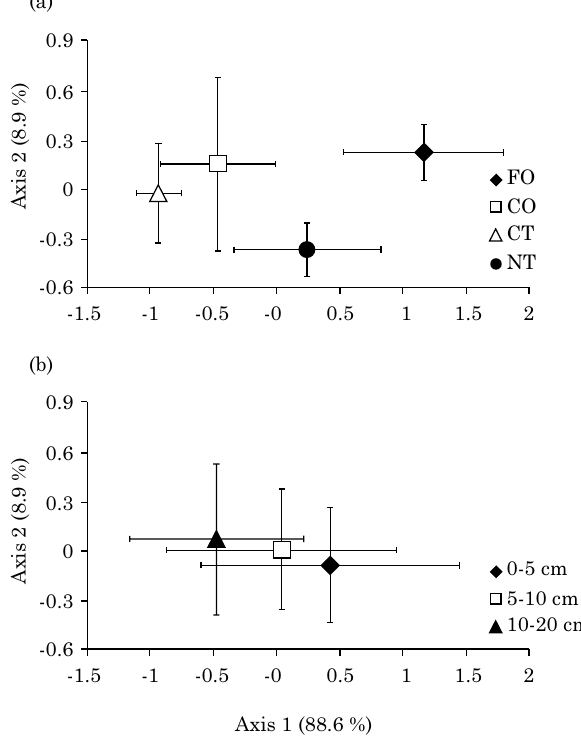
Figure 5. Changes in soil microbial properties after forest conversion to a perennial crop with coffee or annual grain crops (maize and soybeans) in conventional tillage or no-tillage (a) and soil layer (b), according to NMS ordination method. The symbols represent the geometric mean of soil microbial properties in each treatment, while the vertical and horizontal lines indicate ±1SD. 2D stress = 6.96. FO: Forest; CO: Coffee; CT: Conventional Tillage; NT: